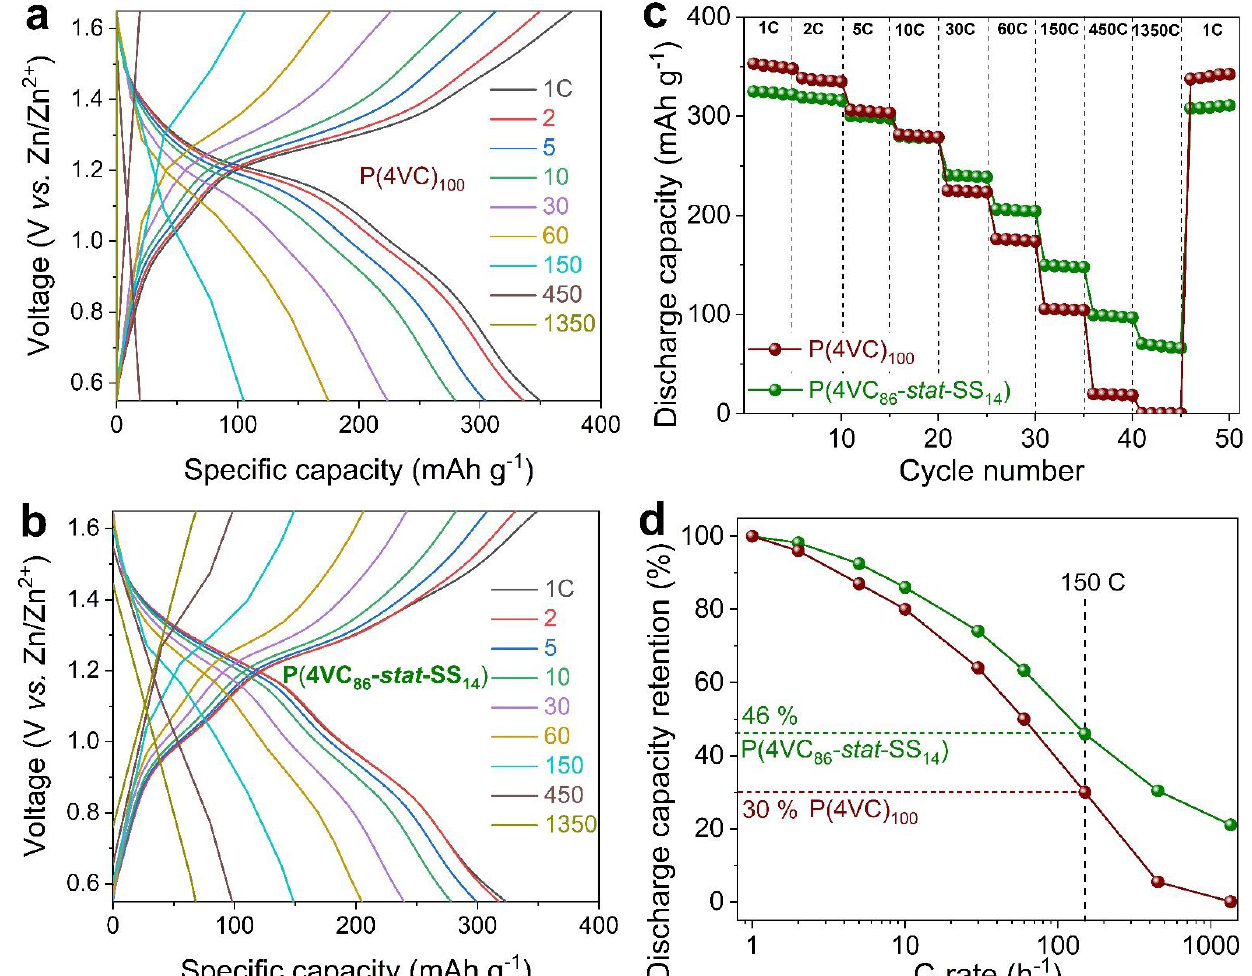
Figure 2. Comparative rate performance of Zn||P(4VC) 100 and Zn||P(4VC 86 - stat -SS 14 ) cells at room temperature. ( a , b ) Representative specific capacity-voltage profiles of Zn||P(4VC) 100 ( a ), and Zn||P(4VC 86 - stat -SS 14 ) ( b ) cells at various C- rates. ( c ) Discharge capacity vs. cycle number, and the corresponding discharge capacity retention at different C-rates ( d ). The discharge capacities at lower C-rates are normalized with respect to the discharge capacity at 1 C.